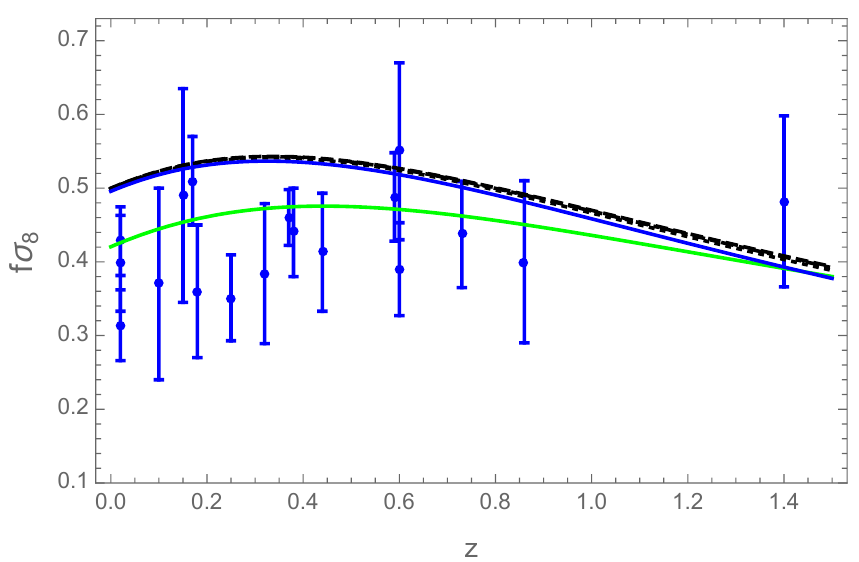
Figure 7 . The evolution of fσ 8 for the model (3.33) for η = 2 / 7 , 1 / 3 , 2 / 5 , 1 / 2 , contrasted with the observed values of fσ 8 from the cited surveys. Note the difficulty of the models in adjusting to measurements of fσ 8 below 0.4 at low redshifts. The curves correspond to the mode k = 300 a 0 H 0 , assuming Ω m 0 = 0 . 3 and initial conditions for eq. (4.18) at z i = 50 . The solid curve corresponds to η = 1 / 2 and the green curve corresponds to Λ